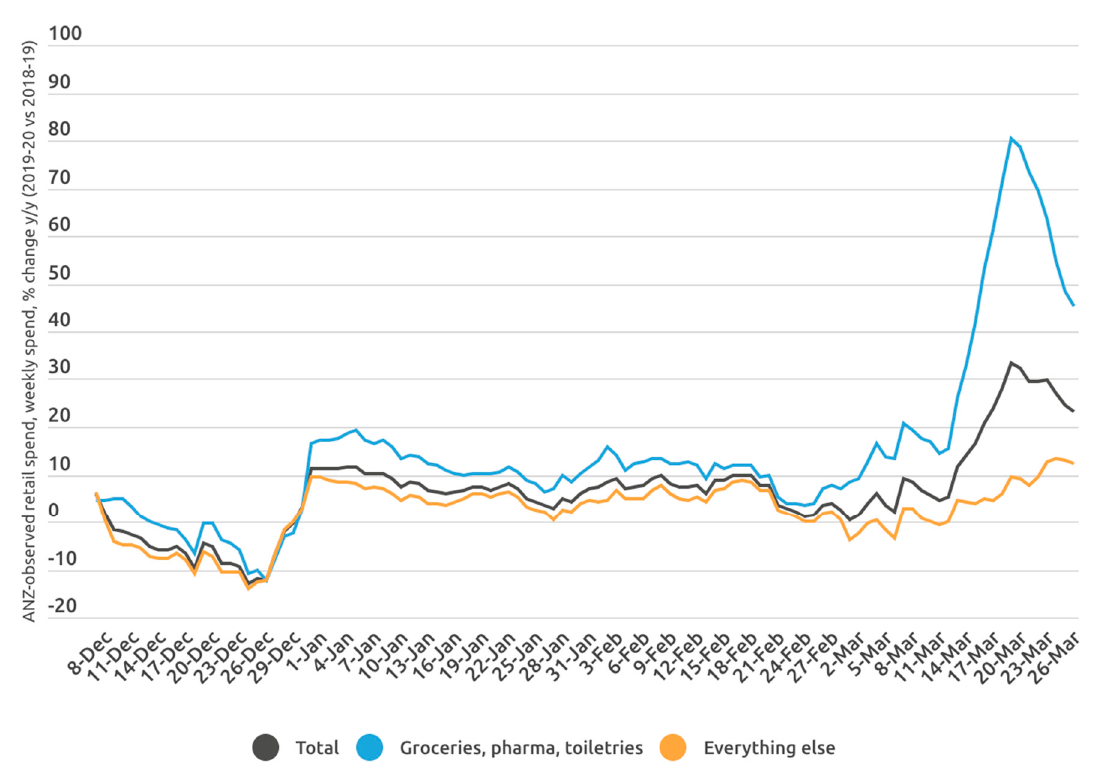
Figure 3. Consumer Spending on Groceries and Toiletries (Source: Timbrell and Plank, Bluenote ANZ,